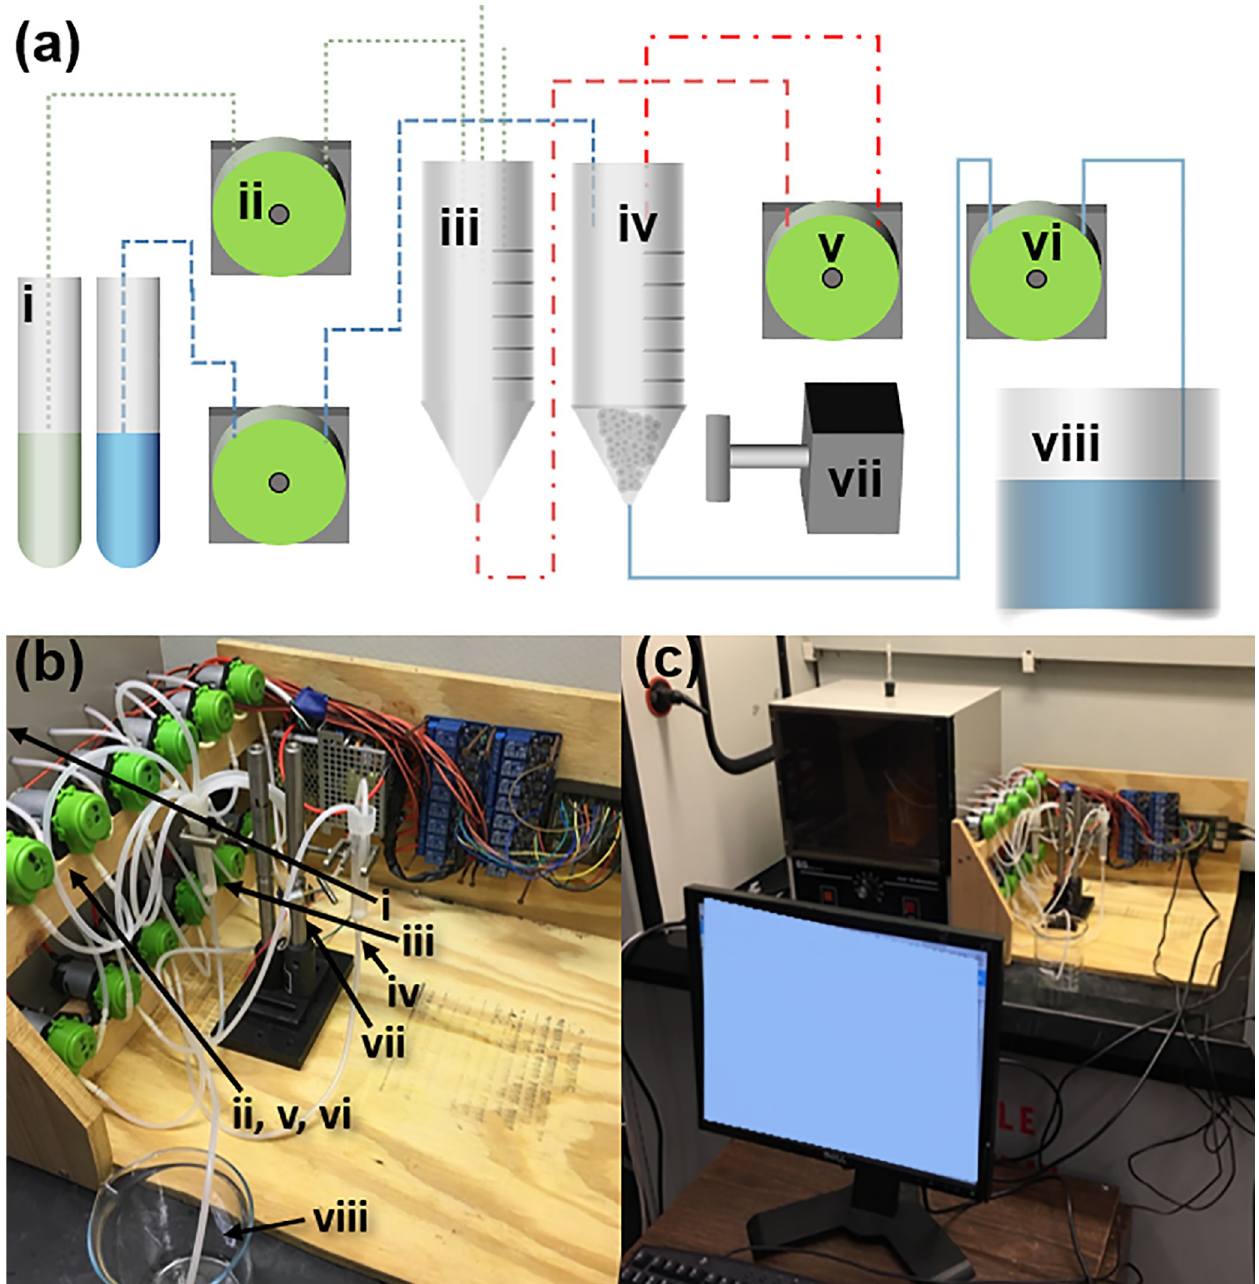
Fig 2. Design of solid phase peptide synthesizer fluid-handling components. (a) Schematic of fluid-handling components. ( i ) Reagents for SPPS, ( ii ) reagent feed pumps, ( iii ) reagent mixing and activation vessel, ( iv ) resin and peptide synthesis vessel, ( v ) transfer pump from activation to peptide synthesis vessel, ( vi ) drainage pump from, ( vii ) custom, inexpensive magnetic stirrer, and ( viii ) waste container for reactor effluents. (b) Photograph of fluid handling components. (c) Photograph of complete setup and physical interface.